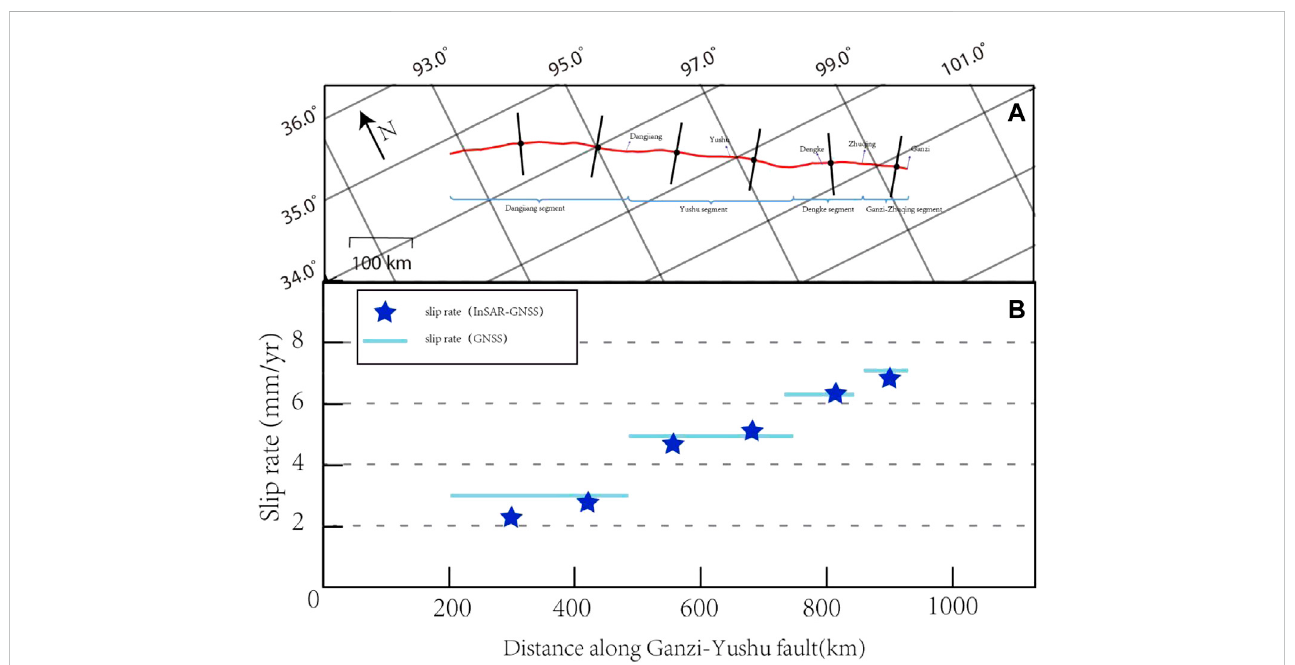
FIGURE 7 Slip rate distribution along the Ganzi-Yushu fault: (A) locations of cross-fault pro fi les. (B) slip rate distributions. Screw dislocation model fi tting results using faultparallel velocity pro fi les from the InSAR-GNSS-integrated horizontal (blue stars). The thick blue lines are estimated slip rates from GNSS velocities